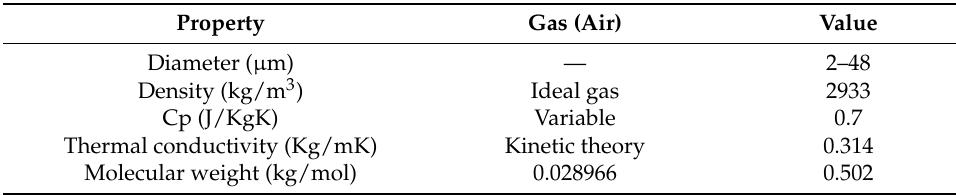
Table 1. Gas and particles properties used for CFD